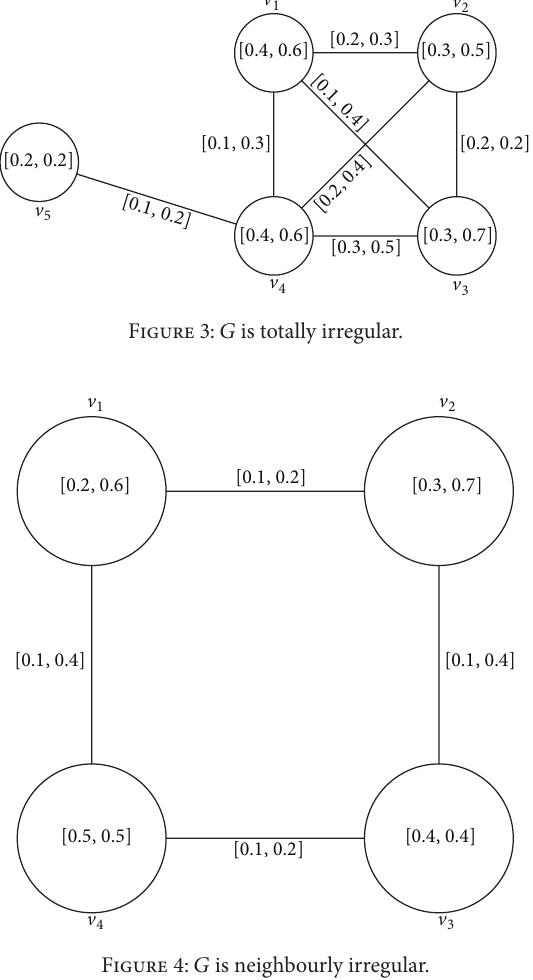
Figure 4: 𝐺 is neighbourly